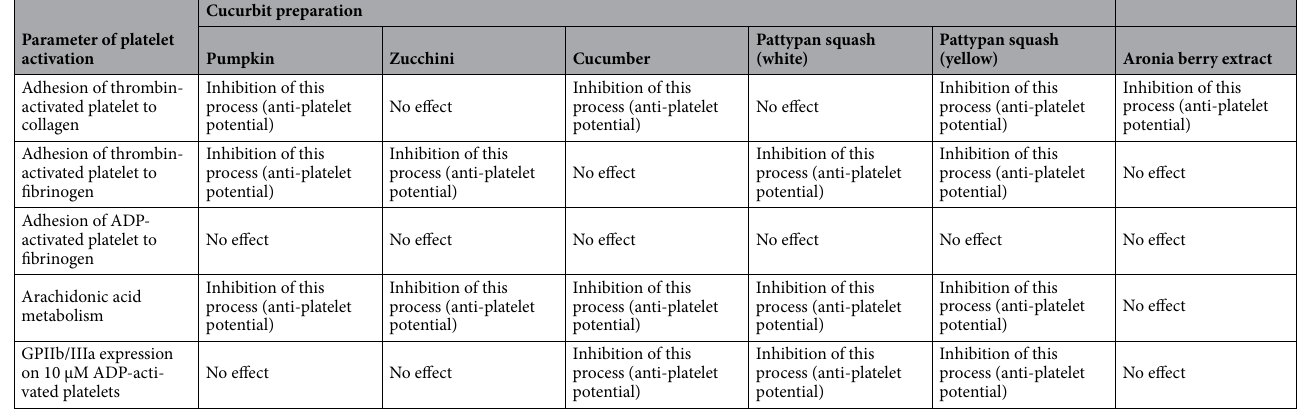
Table 2. Comparation of influence of the five cucurbit preparations (tested concentration—50 µg/mL) on selected properties of activated blood platelets 11,12